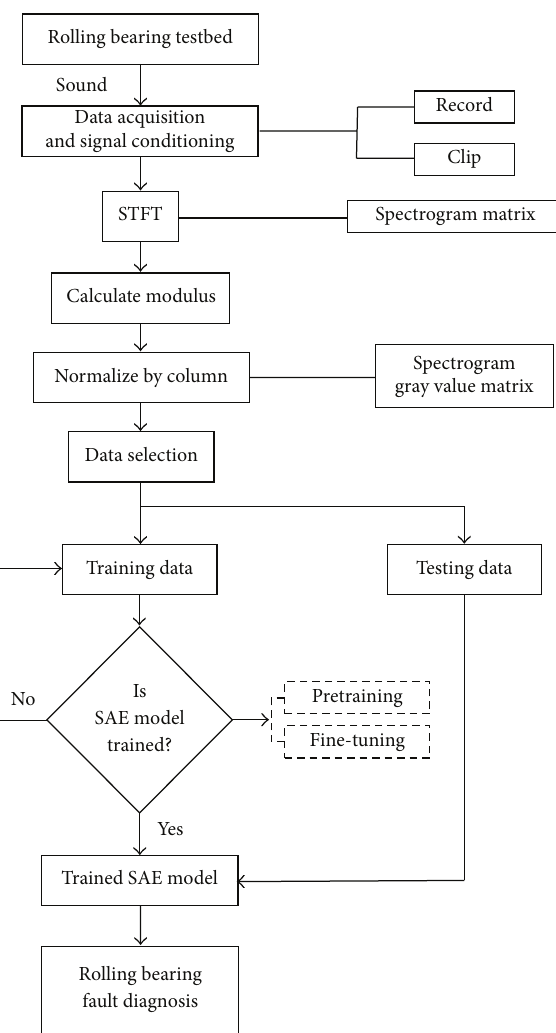
Figure 10: Flowchart of rolling bearing fault